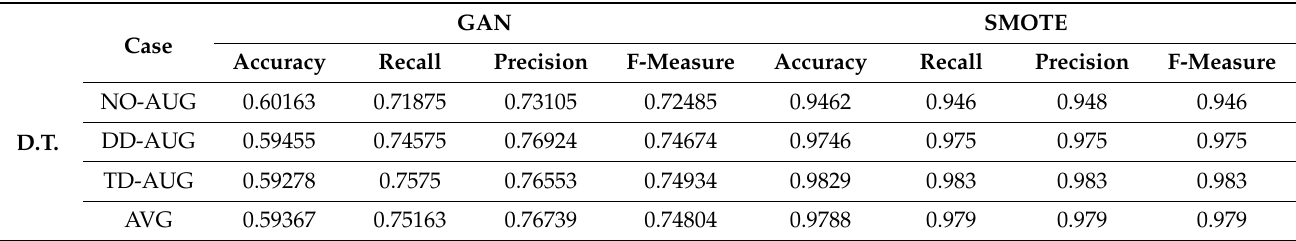
Table 3. Evaluation of D.T. Classifier for NO-AUG, DD-AUG and